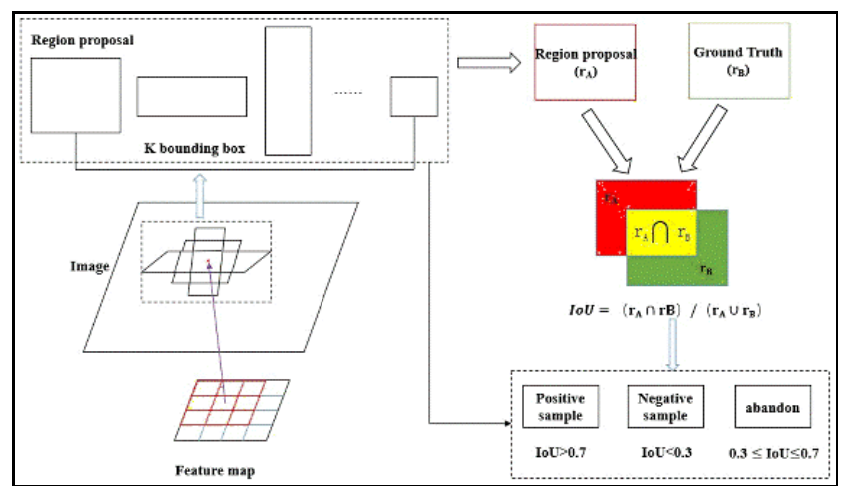
Figure 2. Generation process of rois (region of interest, roi). The input is image. The output is regional proposals. If IoU(Intersection-over-Union) > 0.7, the region proposals will be regarded as positive samples, and if IoU < 0.3, the region proposals will be regarded as negative samples. When 0.3 < IoU ≤ 0.7, the region proposals will be abandon.